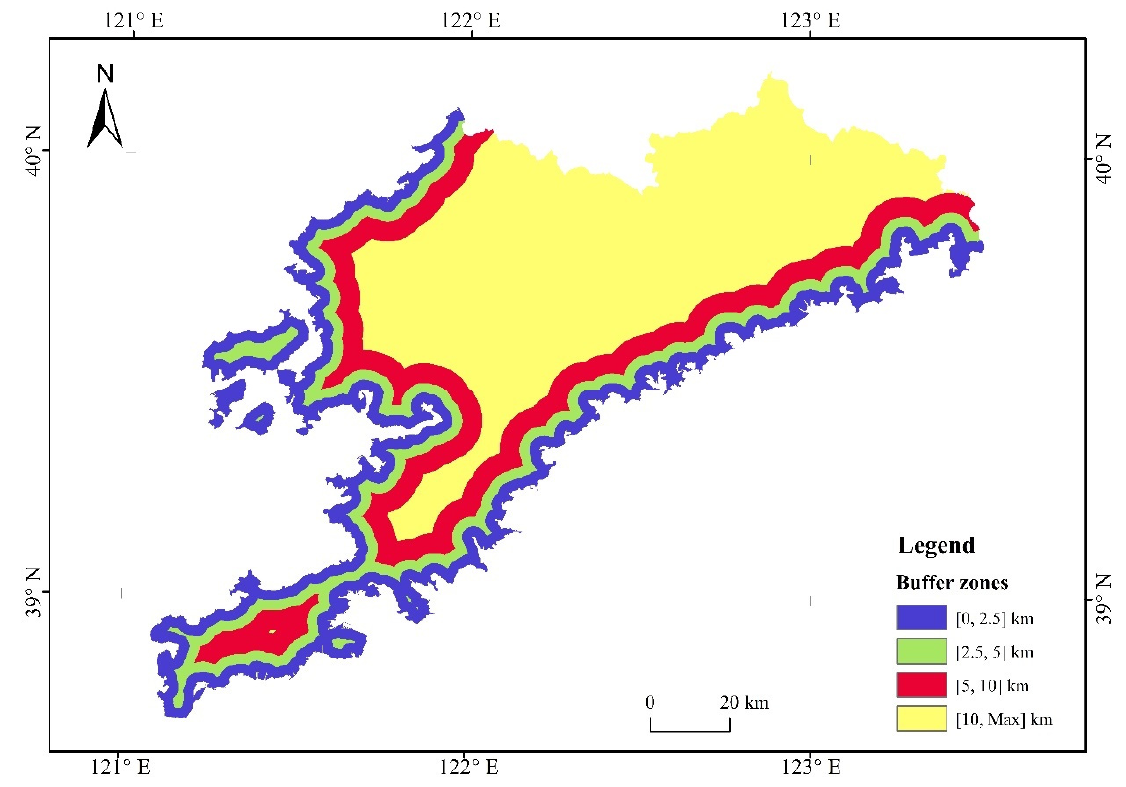
Figure 4. Distribution of sea–land gradient in Dalian.